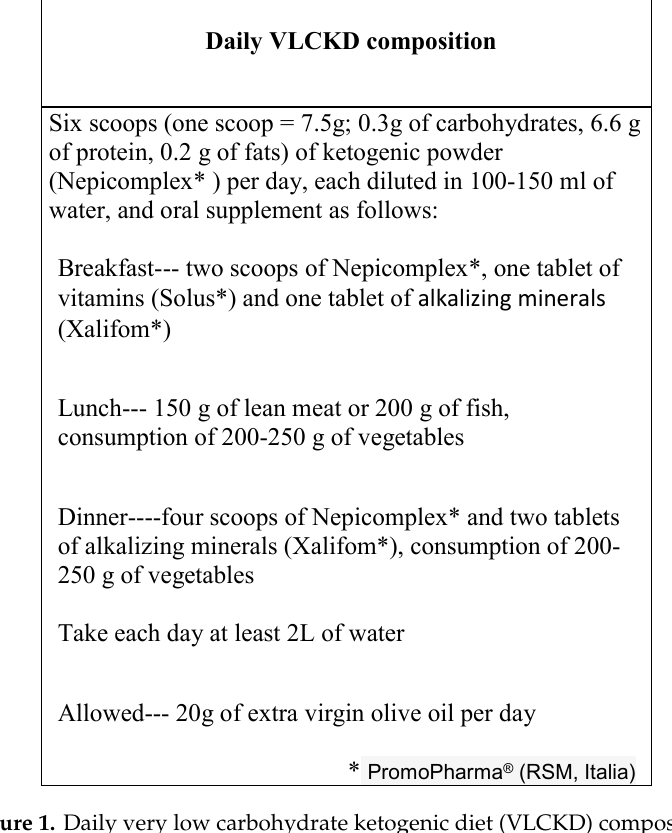
Figure 1. Daily very low carbohydrate ketogenic diet (VLCKD) composition.